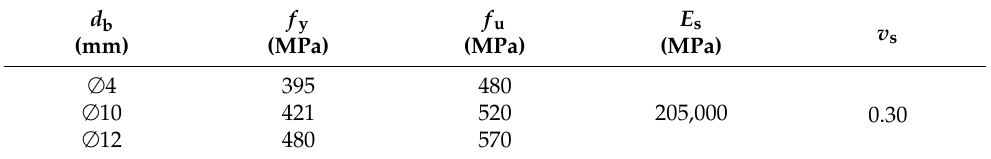
Table 3. Mechanical properties of the reinforcing steel. Adapted from Ref. [23].